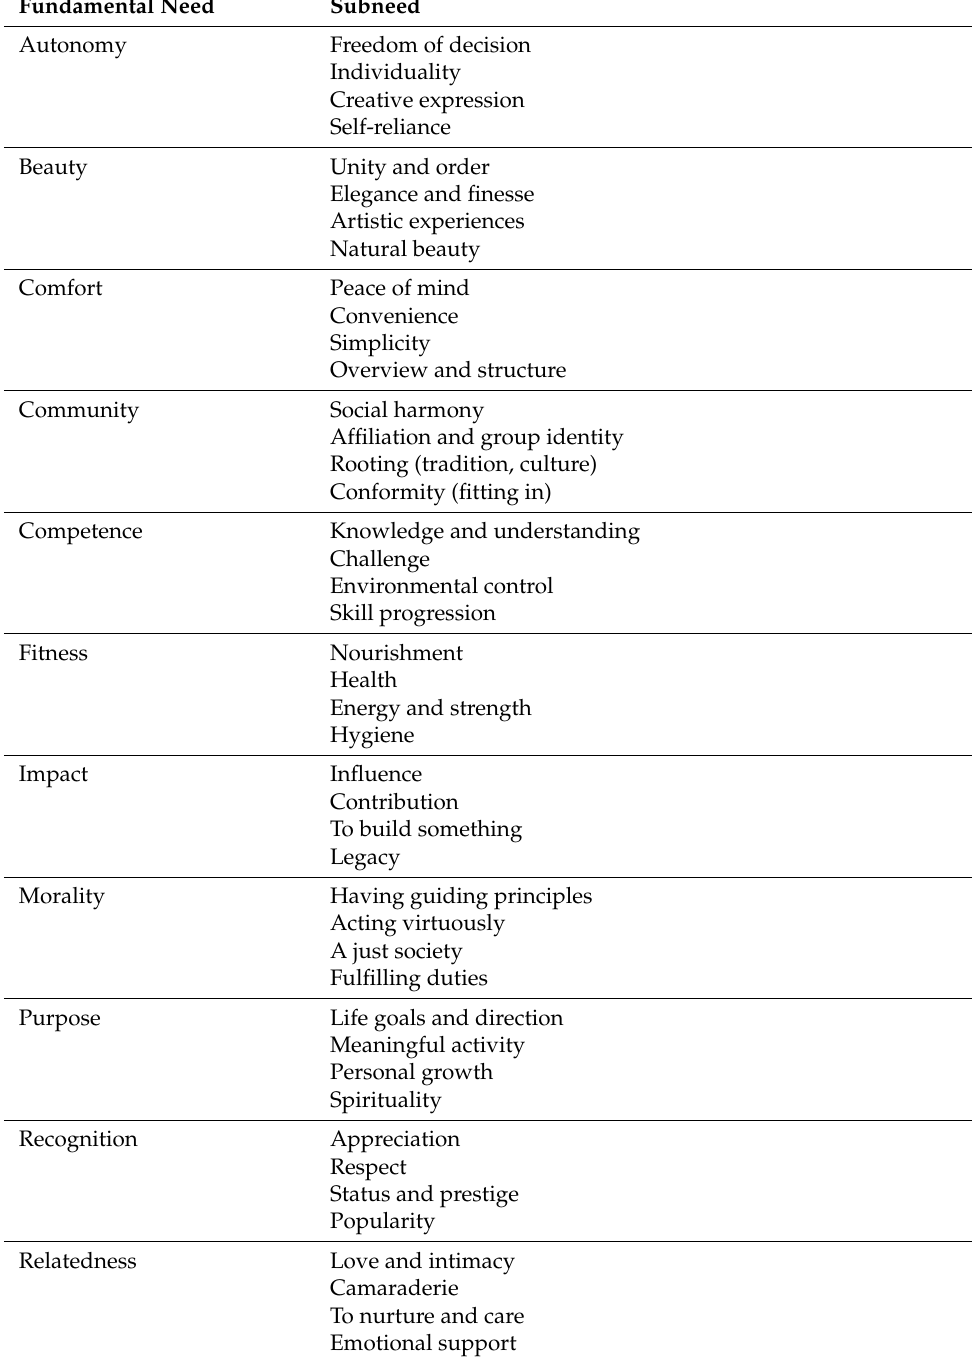
Table 1. Thirteen fundamental psychological needs according to Desmet and Fokkinga